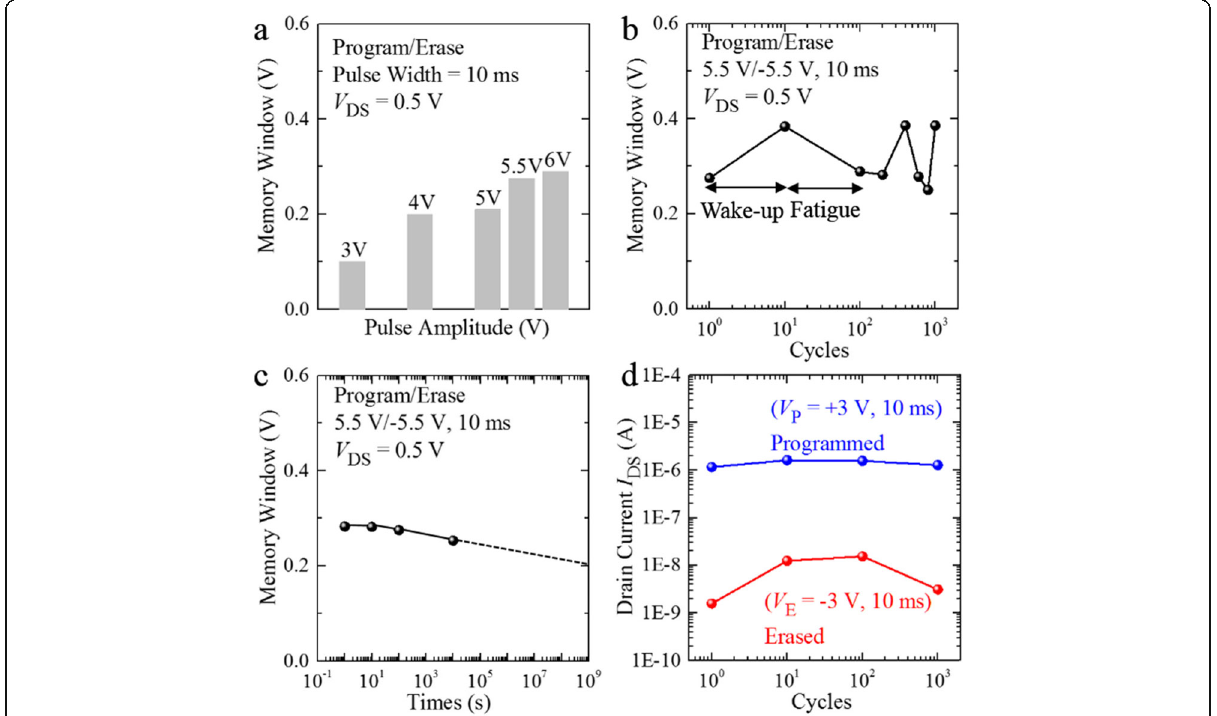
Fig. 4 Memory performances of the HZO/MoS 2 FeFET under P/E pulses. a Extracted MWs (MWs) under P/E pulses with ± 3 V, ± 4 V, ± 5 V, ± 5.5 V, and ± 6 V heights. b Endurance measurements under P/E pulse conditions. c Retention characteristic of the HZO/MoS 2 FeFET. d Endurance of the HZO/MoS 2 FeFET for 10 3 cycles under the P/E pulses with ± 3 V